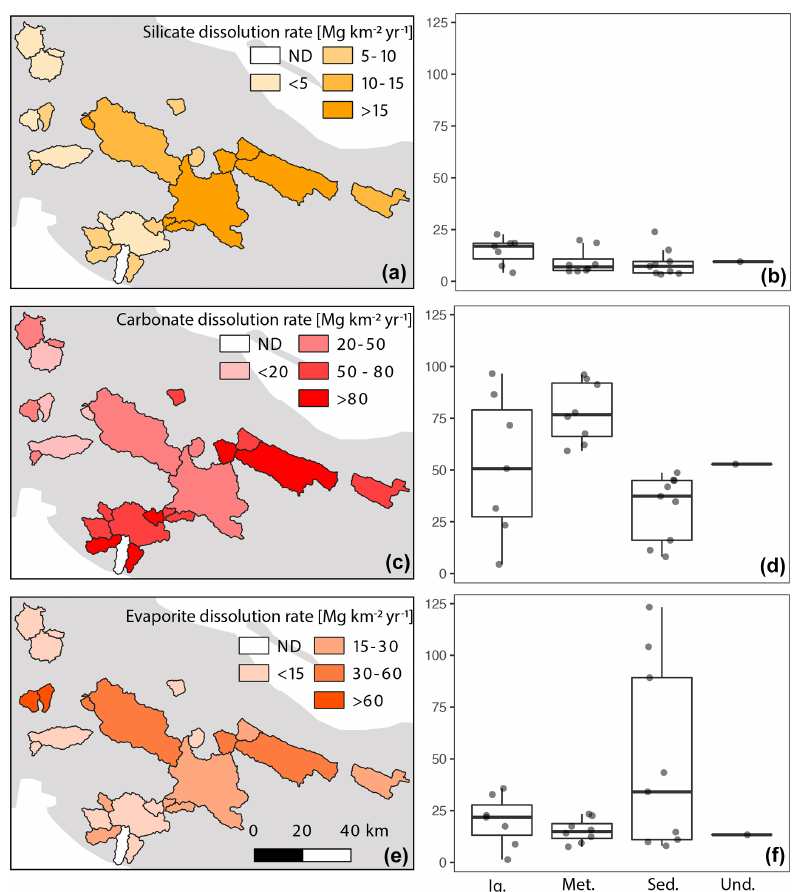
Figure 4. Dissolution rates partitioned by lithology. (a, b) Silicate. (c, d) Carbonate. (e, f) Evaporite. Darker colors represent higher rates. Box plots show the maximum and minimum values in the lines extending from the box; the upper side of the box represents the upper quartile, the line inside the box represents the median value, and the bottom of the box represents the lower